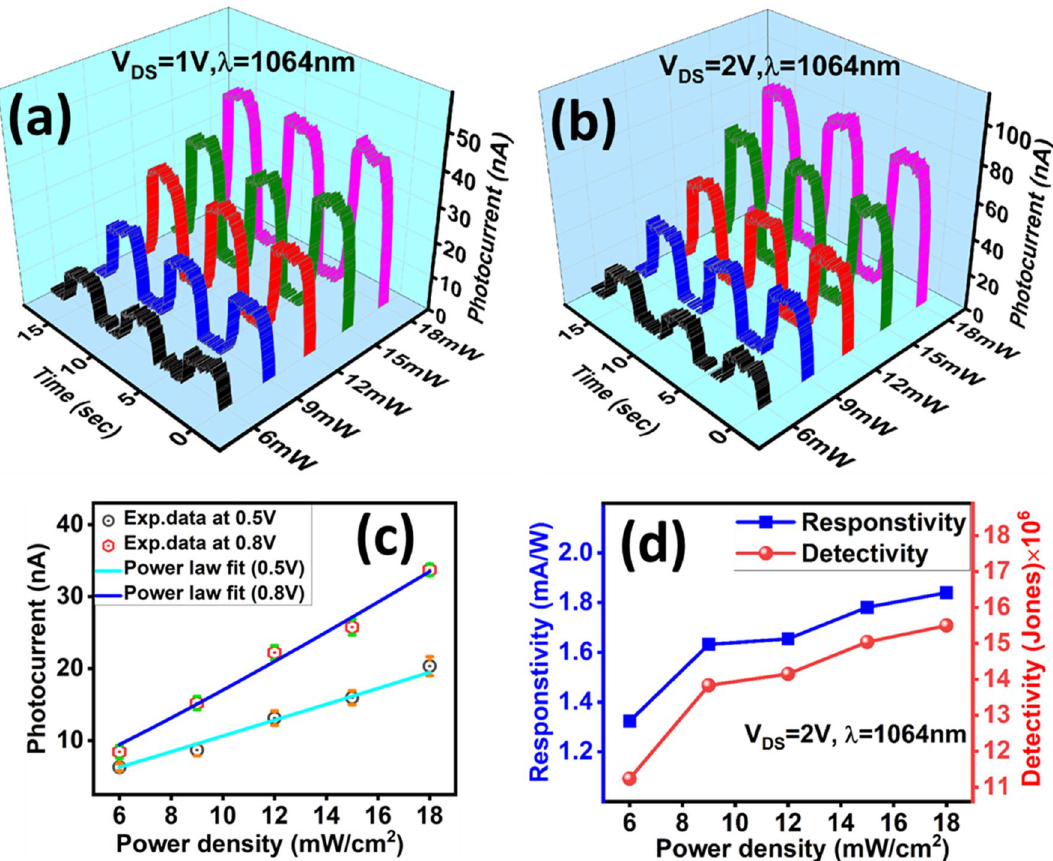
Figure 3. power dependent photocurrent measurements at different bias voltages 1 V ( a ), 2 V ( b ) and 0.5 V& 0.8 V ( c ). Blue and cyan line curves represent power law fit ( c ). ( d ) shows responsivity (blue curve) and detectivity (red curve) measured at bias voltage 2